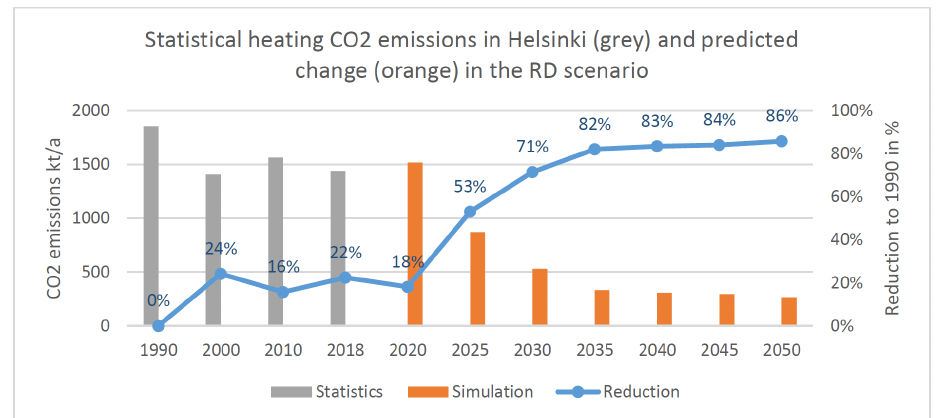
Figure 13. Statistical (gray) and predicted (orange) CO 2 emissions in Helsinki with a 3% refurbishment rate and CO 2 efficient district heating